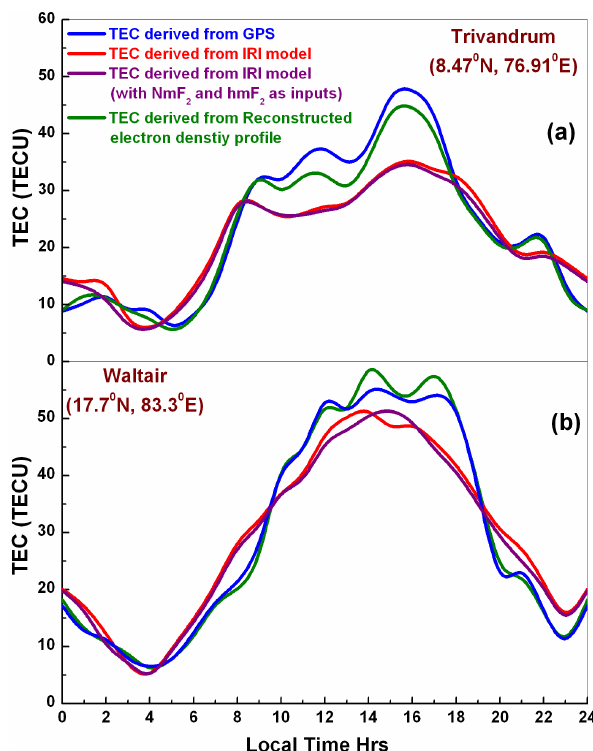
Fig. 6. Diurnal variations of TEC derived using reconstructed pro- file and IRI model derived TEC along with the GPS measured TEC over (a) Trivandrum and (b)